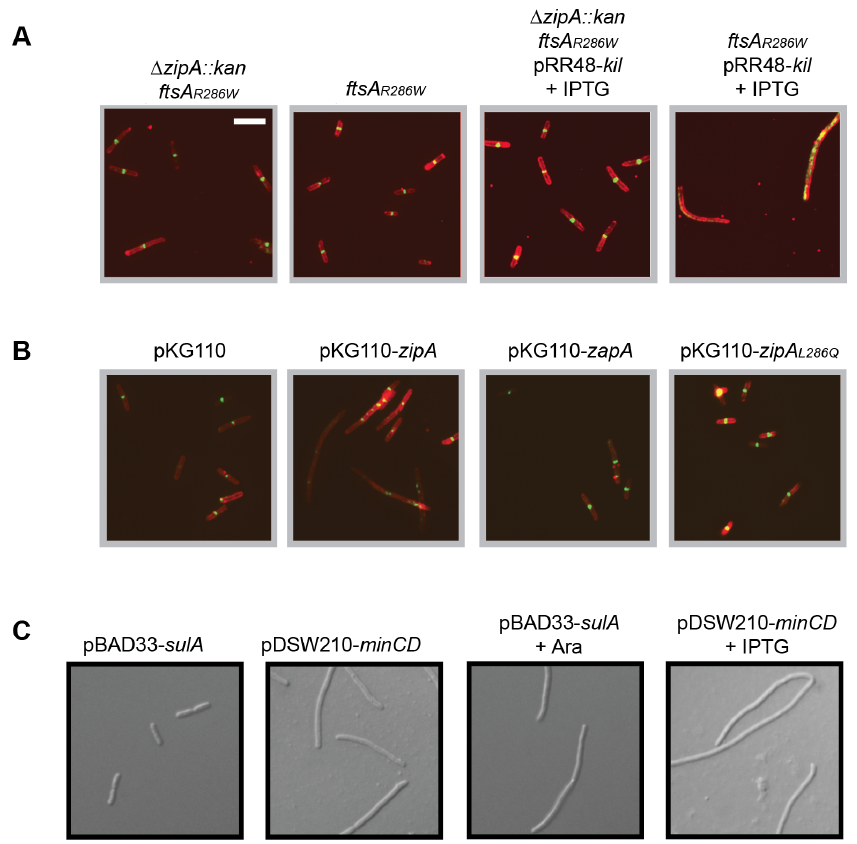
Figure 6. Kil activity invivo requires ZipA. (A) Cells harboring ftsA R286W to allow bypass of zipA ( D zipA::aph ) are resistant to kil expression, but are not resistant when containing ftsA R286W alone. Shown are representative IFM micrographs of cell wall (red) or a -FtsZ (green) signal from fixed cells of the indicated genotypes in a WM1074 pRR48- kil background with ( + IPTG) or without kil induction for 40 minutes. Cell wall and a -FtsZ signal are shown as in Figure 2. Scale bar=5 m m. (B) Complementation of ftsA R286W D zipA::aph with zipA WT in trans from pKG110 specifically restores Kil- mediated filamentation. Shown are representative IFM micrographs of cell wall (red) or a -FtsZ (green) signal from fixed cells grown under kil -inducing conditions for 40 minutes (1 mM IPTG) of the indicated genotypes in a WM1074 ftsA R286W D zipA::aph pRR48- kil background. Signal and scale as in (A). (C) SulA and MinCD activity do not require zipA . Representative DIC micrographs of live cells with indicated plasmids in a WM1074 ftsA R286W D zipA::aph background grown with (bottom panels) or without (top panels) the indicated inducers for 40 min. Scale as in